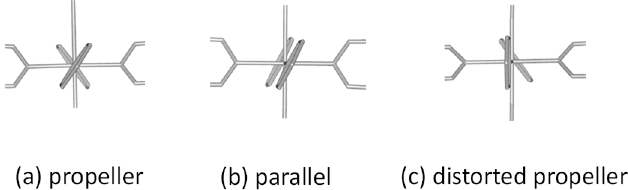
Table 1. Summary of crystal structures and their spin-crossover (SCO) phenomena